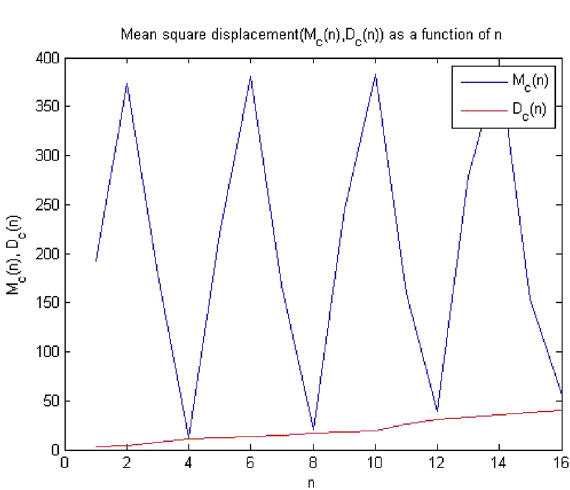
Figure 18. Plot of MSD corresponding to chaotic